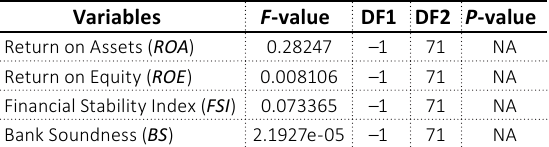
Table 3. PF test between pooled and fixed effect regression